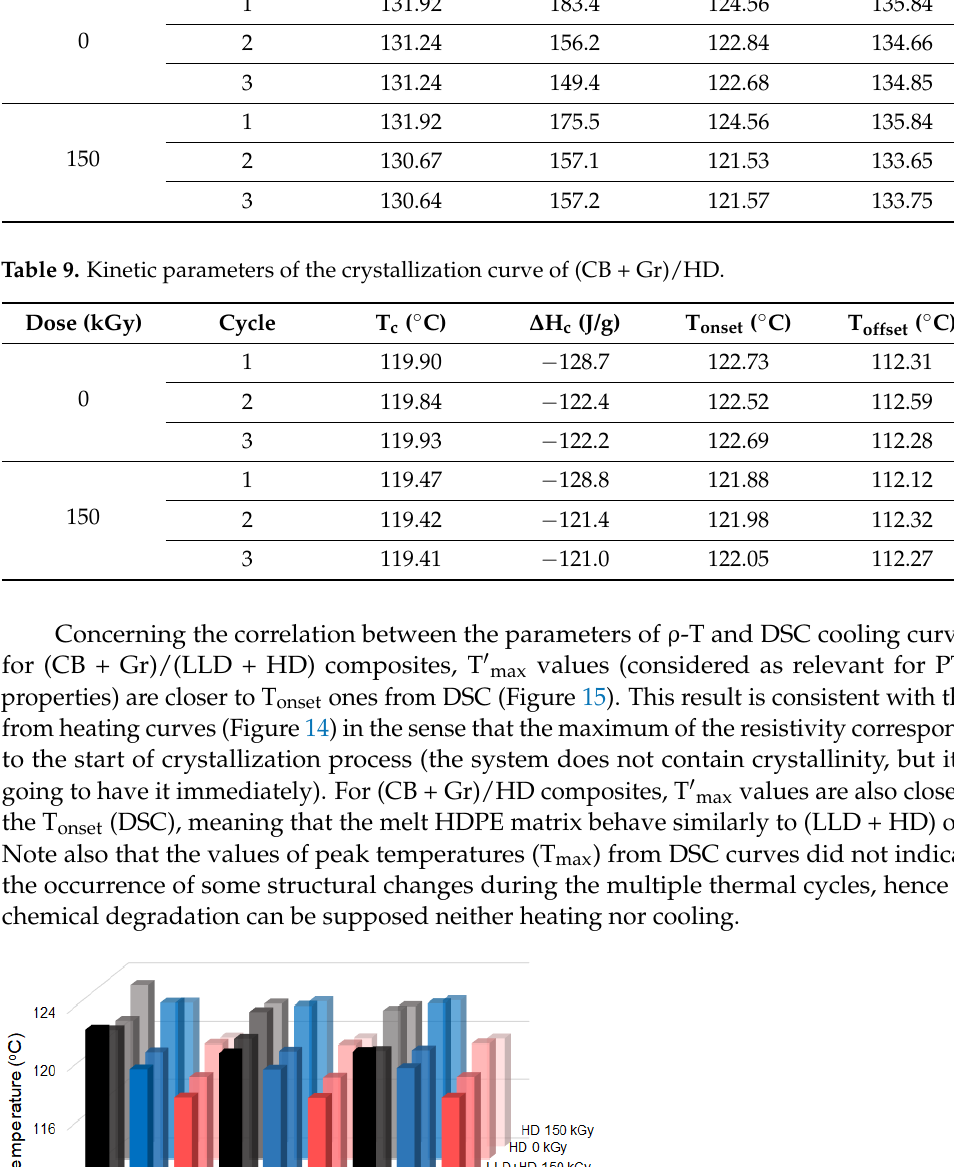
Table 8. Kinetic parameters of the melting curve of (CB + Gr)/HD.